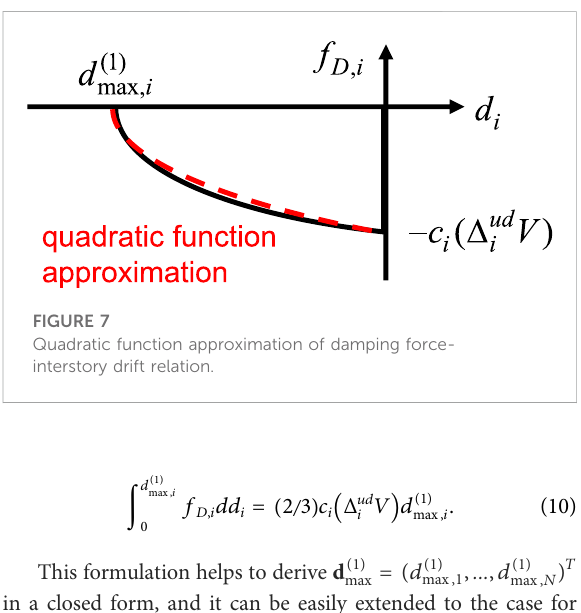
FIGURE 7 Quadratic function approximation of damping force- interstory drift relation.